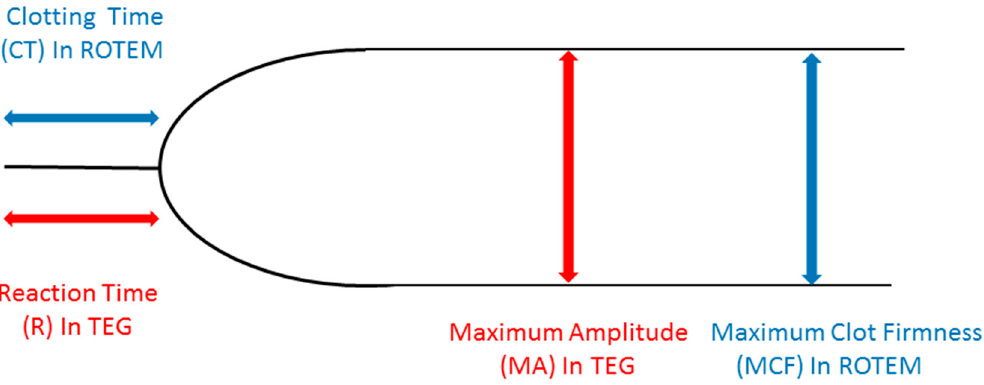
Figure 1. A standard viscoelastic test tracing. ROTEM: rotational thromboelastometry;